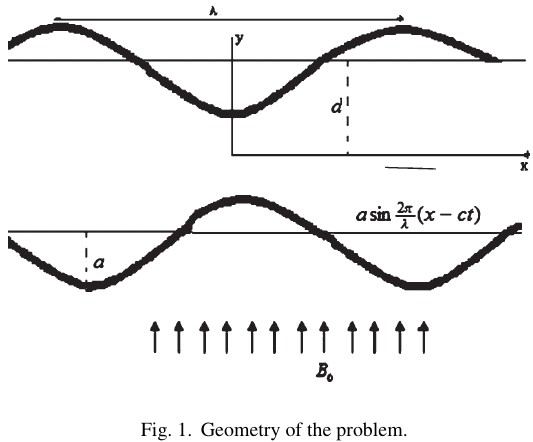
Fig. 1. Geometry of the